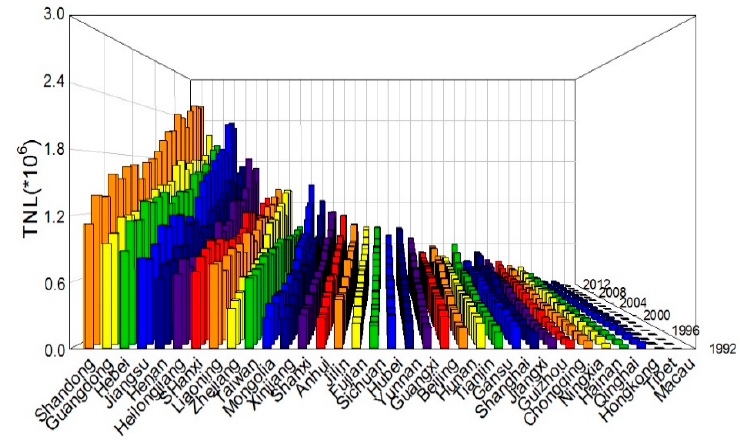
Figure 9. Total nighttime light (TNL) at the provincial scale in China.